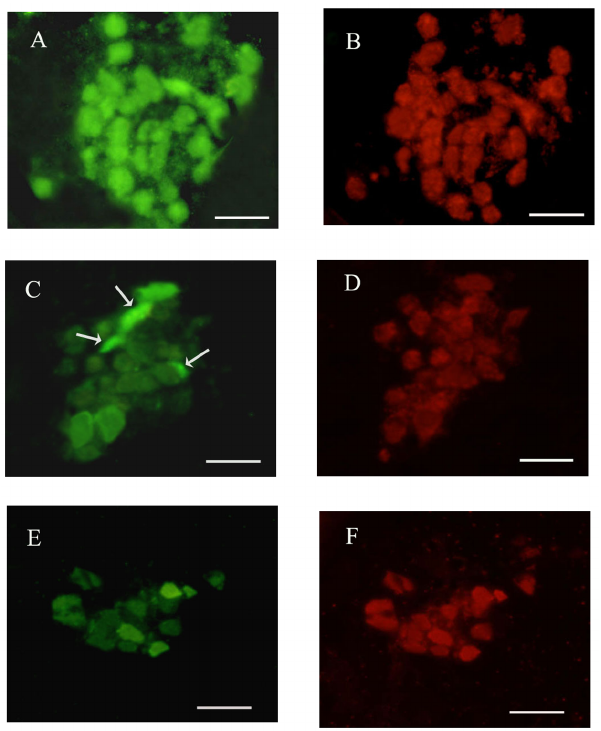
Figure 1. Immunohistochemical co-localization of GluN 1 , GluA 1–4 , GluK 1–3 with the neuronal marker HuC/D in rat small intestine myenteric ganglia cultures in normal metabolic conditions. GluN 1 antibody stained the somata of the majority myenteric neurons (A, B). GluA 1–4 antibody stained the somata of myenteric neurons and the cytoplasm of enteric glial cells (asterisks) (C, D). GluK 1–3 stained the cytoplasm of myenteric neurons and of enteric glial cells (asterisks). The neuronal marker HuC/D stained the somata of all myenteric neurons (B–D). Bar 10 m